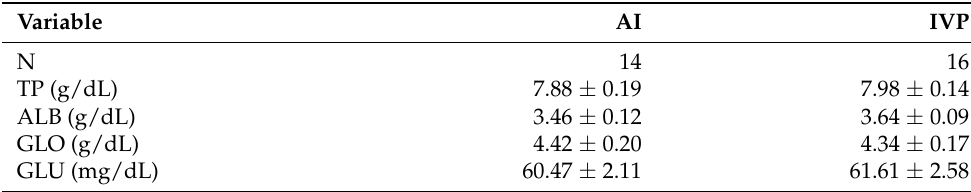
Table 4. Biochemical data from pigs derived from artificial insemination (AI) and in vitro embryo production (IVP) at 3.5 years of age. The parameters analyzed were total protein (TP), albumin (ALB), globulin (GLO), and glucose (GLU). Data are expressed as mean ± s.e.m. Variable N TP (g/dL)